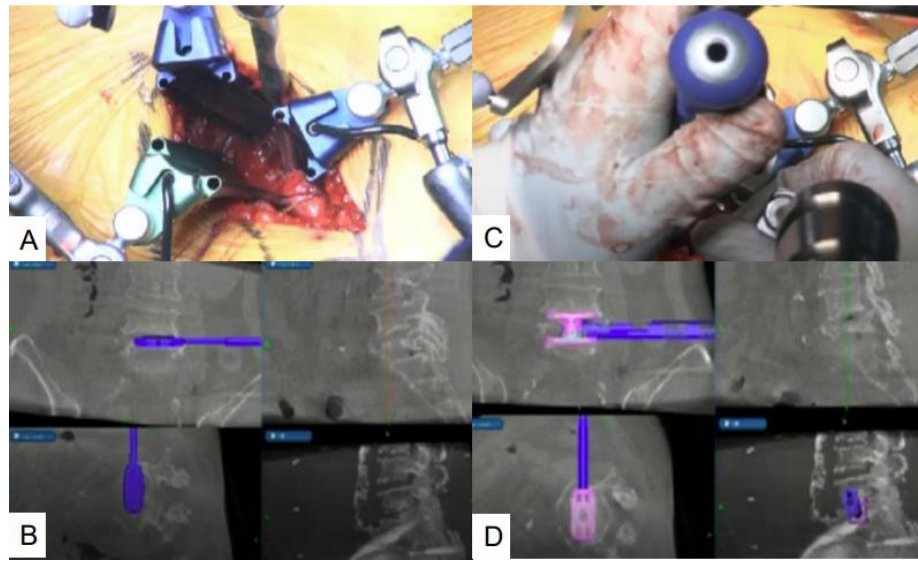
Figure 8. Navigated expandable cage, T2 Stratosphere TM Expandable Corpectomy System. ( A , B ) Navigated trial; ( C , D ) Navigated expandable cage.